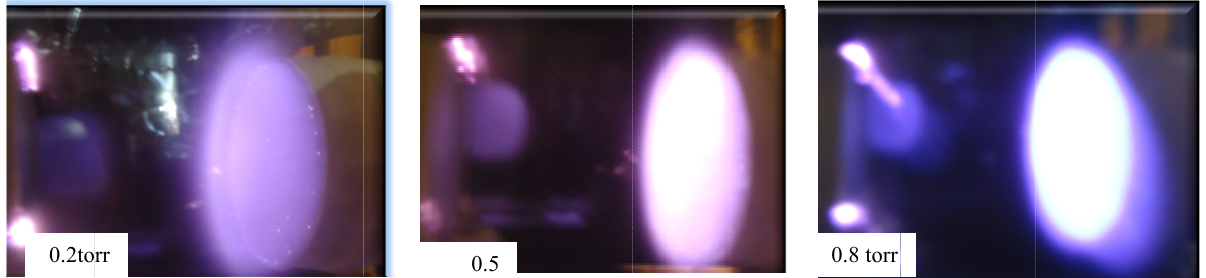
Fig.4: Pho otographs of